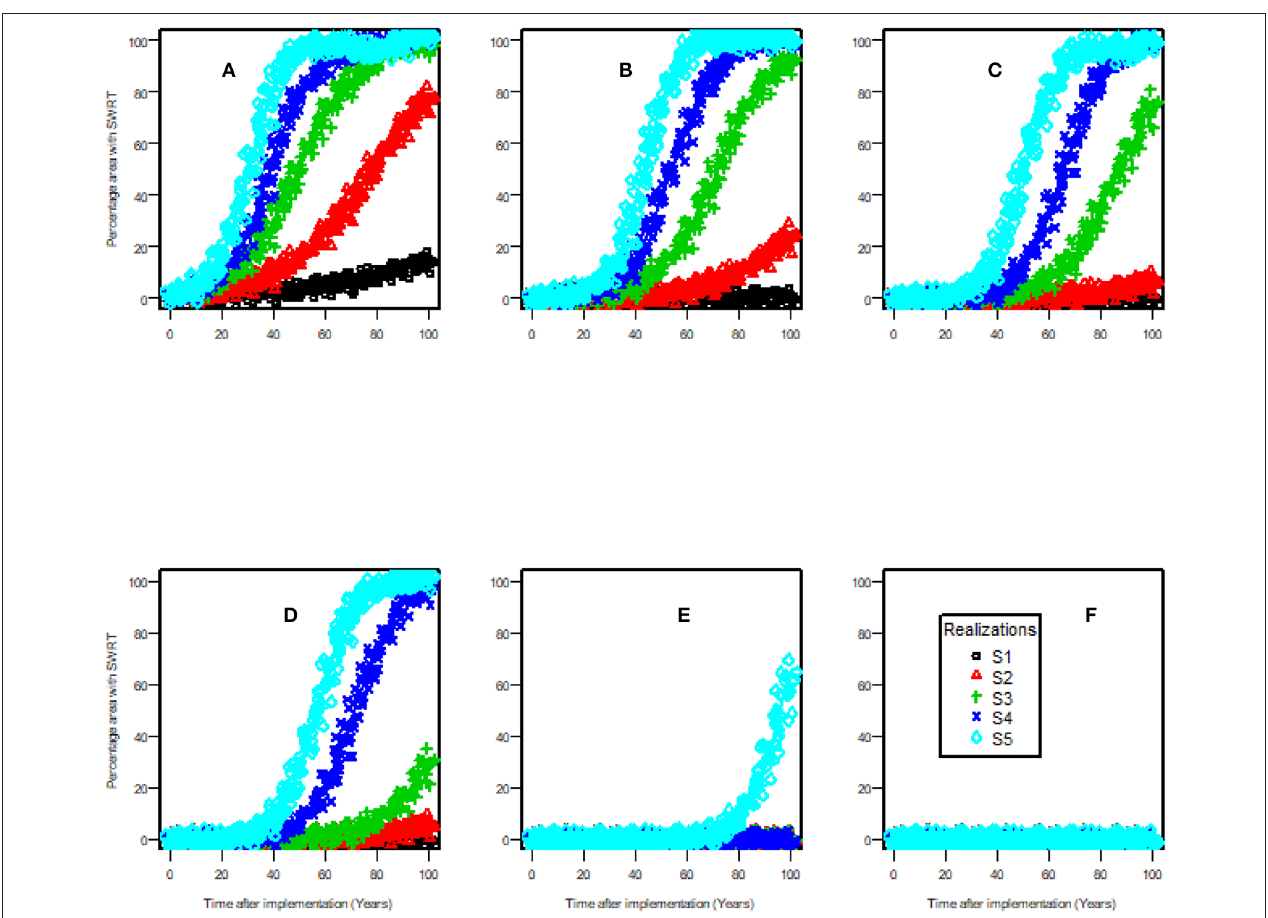
FIGURE 3 | Percentage of area projections with SWRT in stochastic simulations of five SWRT diffusion rates for the different numbers of new adopters per year (S1 = 1, S2 = 2, S3 = 3, S4 = 4, and S5 = 5) with six initial values (N0) in percentage area [ (A) N0 = 1, (B) N0 = 0.1, (C) N0 = 0.05, (D) N0 = 0.01, (E) N0 = 0.005, and (F) N0 =